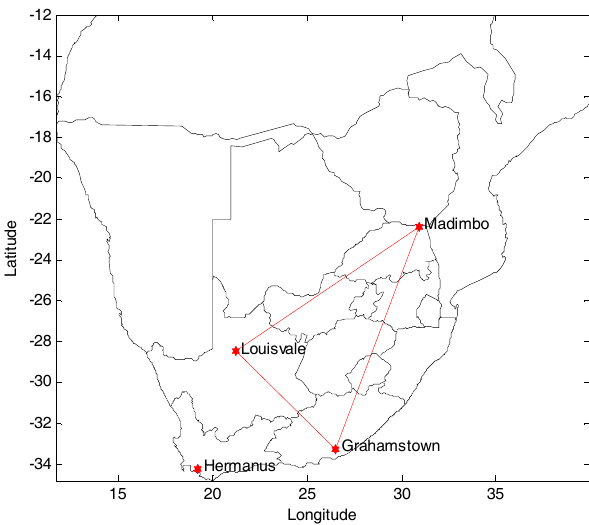
Fig. 1. Locations of the South African ionosonde stations. SABIM is used inside the marked triangular